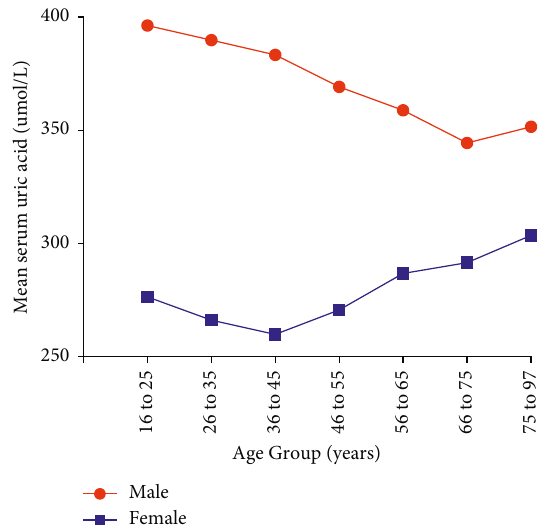
Figure 2: Mean serum uric acid in different age